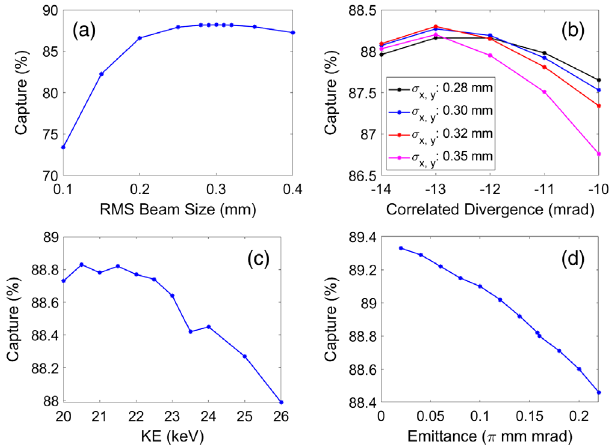
FIG. 16. ASTRA simulations showing scans of the initial beam parameters: (a) transverse rms beam size; (b) correlated diver- gence; (c) kinetic energy; (d) emittance.